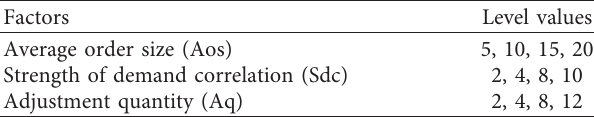
Table 1: Summary of the factorial design of